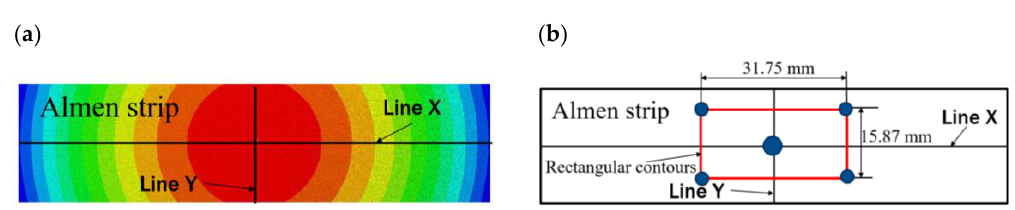
Figure 13. Direct measurement of arc height. ( a ) Deflection of the Almen strip. ( b ) Measured longitudinal deflection and transverse direction of the rectangular contours.